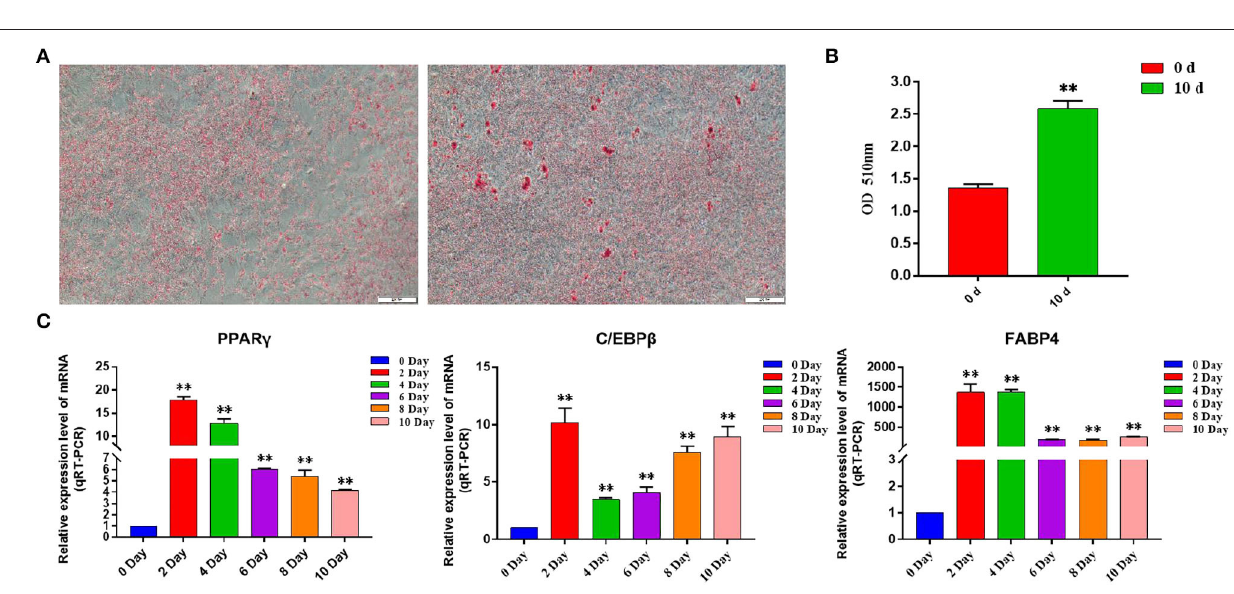
FIGURE 7 | Induction of primary adipocyte differentiation. (A) Bovine adipocytes were stained with oil red O at 0 d (left) and 10 d (right) after adipogenic differentiation; (B) Absorbance measurements at 510nm. Control: isopropyl alcohol, 0 d: adipocyte extracts from 0 day of induced differentiation, 10 d: adipocyte extracts from 10 day of induced differentiation; (C) Expression of adipogenic marker genes in the process of adipogenic differentiation. Compared with the control, “*” means significant difference ( p < 0.05), and “**” means extremely significant difference ( p <